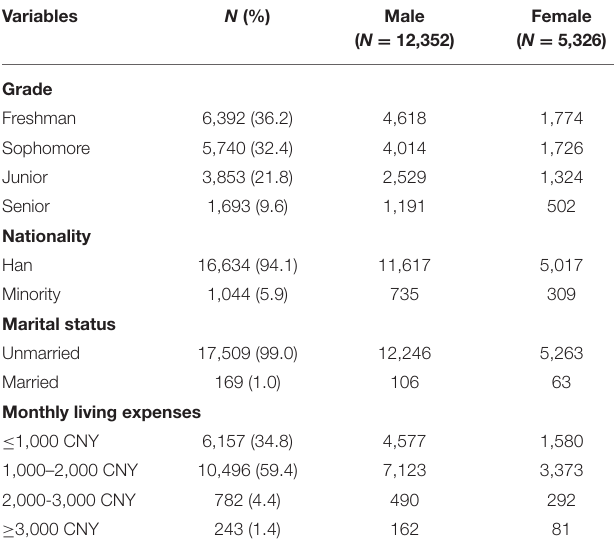
TABLE 1 | Demographic characteristics of participants.